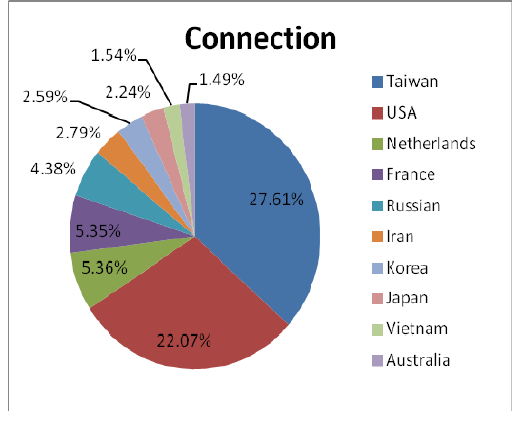
Fig.10. Graphical representation of Top 10 source